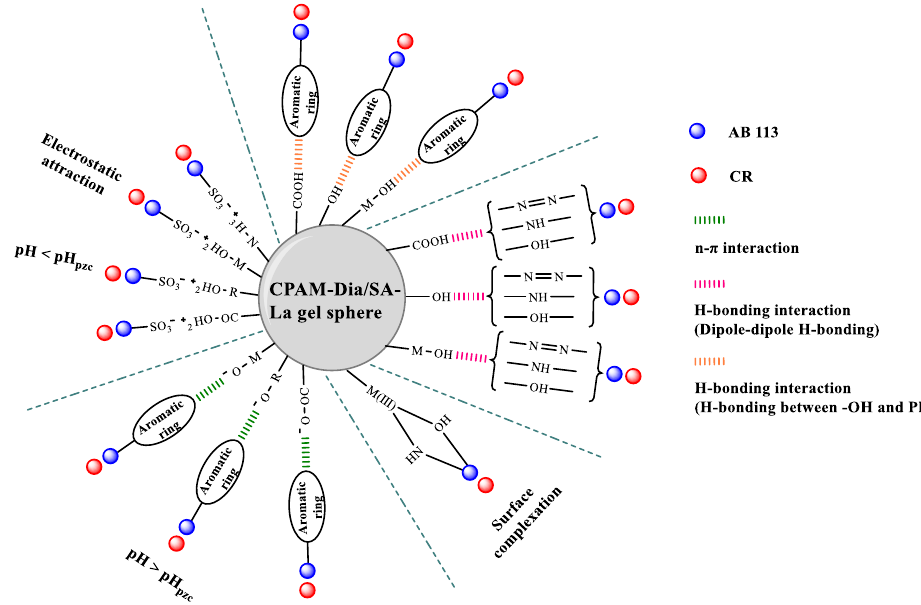
Figure 7. Interaction sketch between the gel composite and anionic dyes